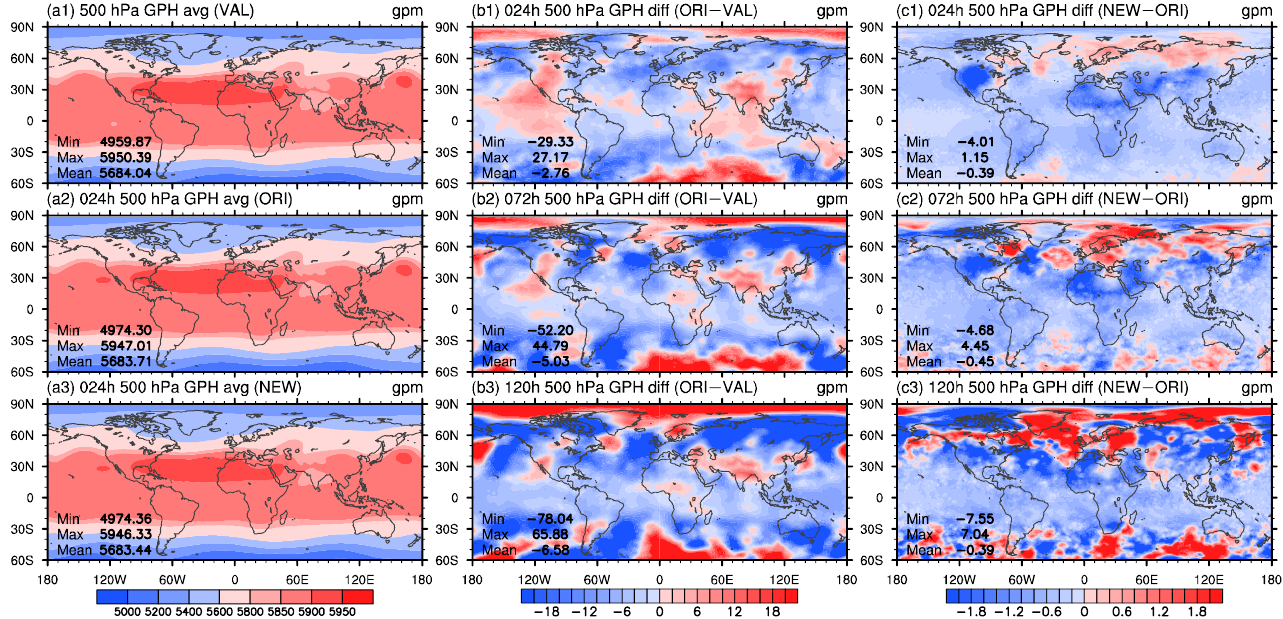
Figure 2. Spatial distribution of time-averaged 500 hPa geopotential height (GPH) derived from ( a1 ) ERA5 reanalysis dataset, ( a2 ) GRAPES_ORI 24 h forecast results, and ( a3 ) GRAPES_NEW 24 h forecast results; difference in time-averaged 500 hPa GPH between ( b1 ) GRAPES_ORI 24 h forecast results, ( b2 ) GRAPES_ORI 72 h forecast results, ( b3 ) GRAPES_ORI 120 h forecast results and ERA5; difference in time-averaged 500 hPa GPH between ( c1 ) GRAPES_NEW 24 h forecast results, ( c2 ) GRAPES_NEW 72 h forecast results, ( c3 ) GRAPES_NEW 120 h forecast results and GRAPES_ORI forecast results at the corresponding forecast lengths (units: gpm).